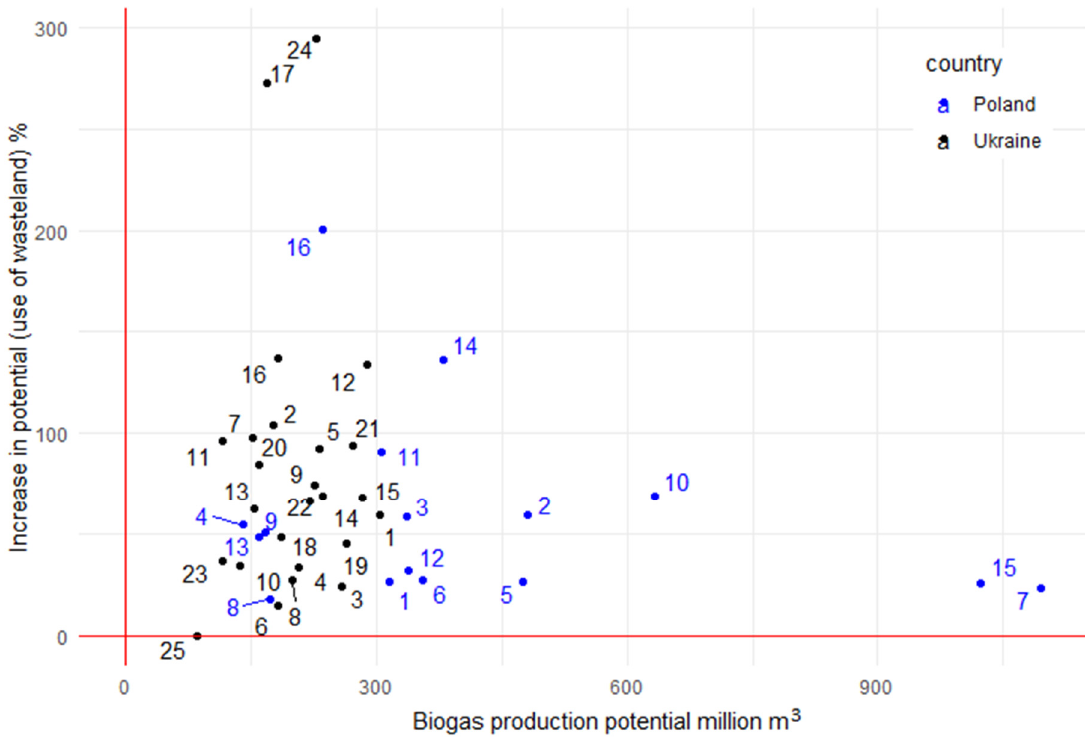
Figure 5. The basic potential of biogas production and the possibilities of increasing it based on the cultivation of maize in wasteland. Source: Own study.